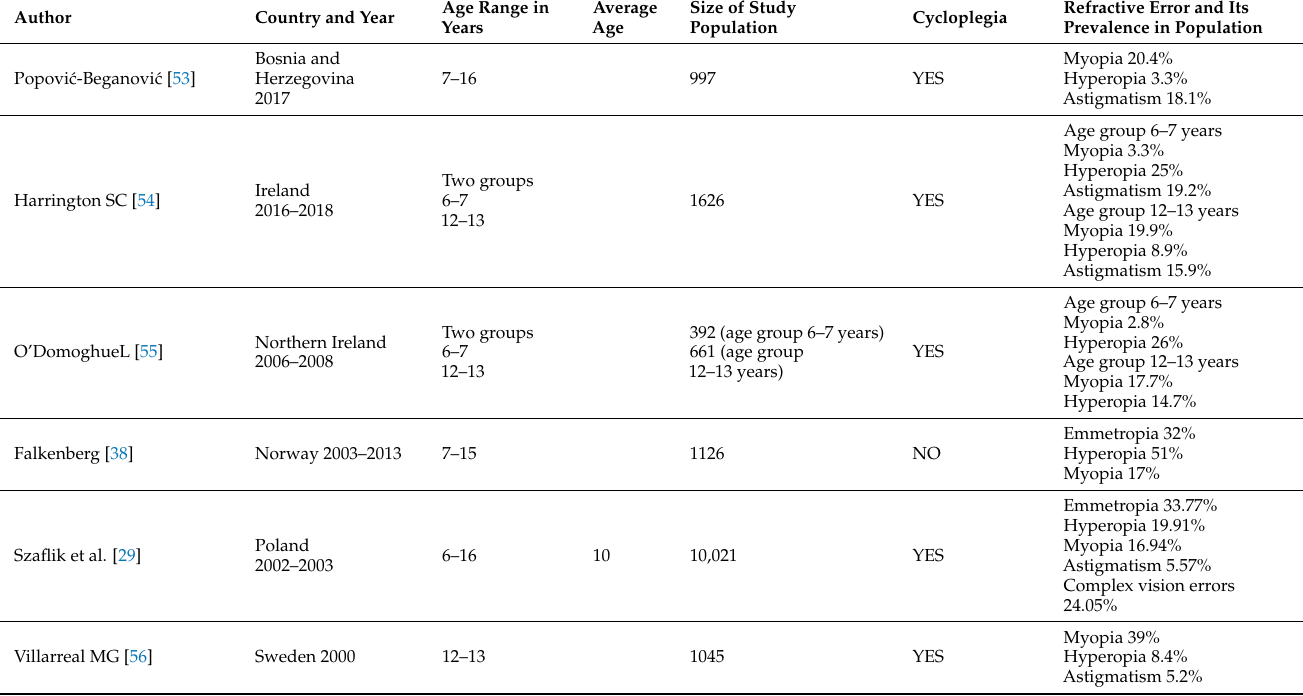
Table 2. Prevalence of refractive errors among children in Europe, according to the literature [38,53–56].